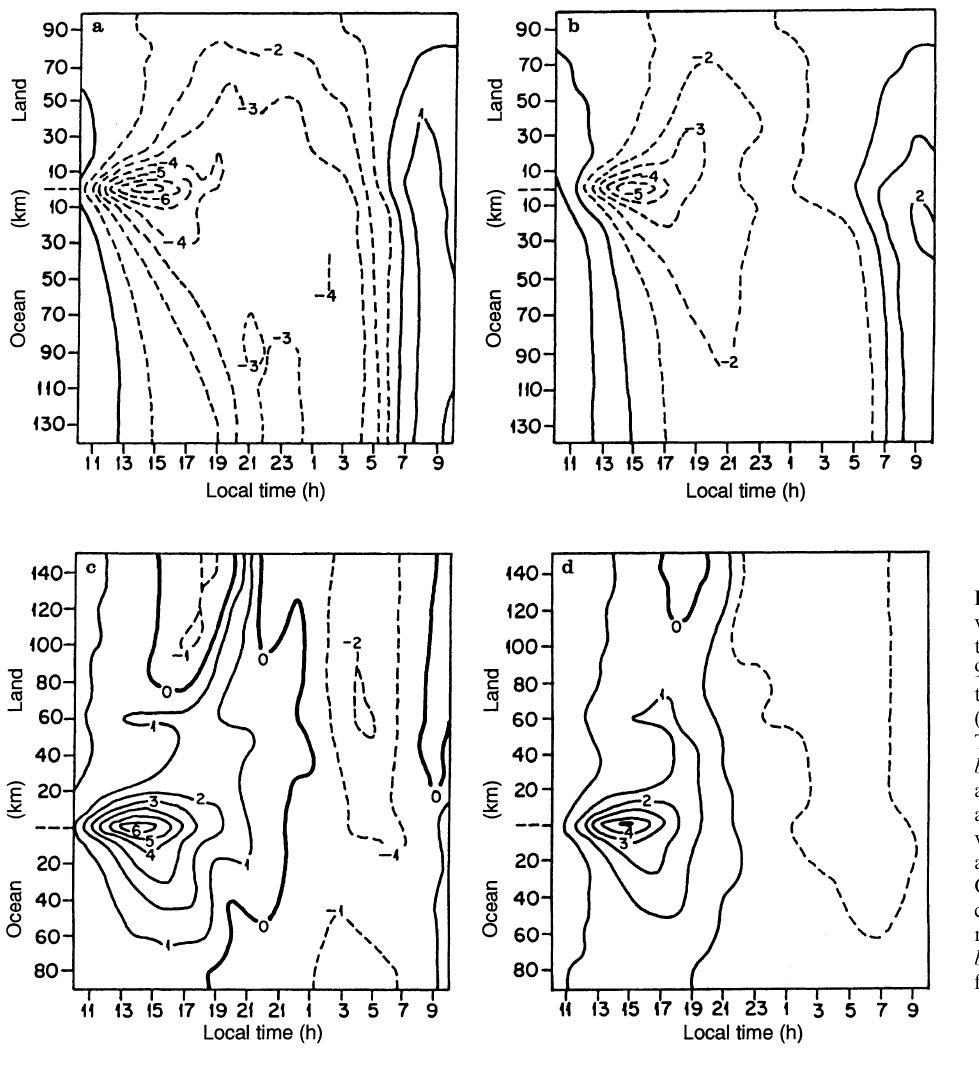
Fig. 6a–d. Simulated temporal variation of the horizontal ex- tension of the sea-breeze at the 990 hPa level: a EW variation of the u-component along line AB (Fig. 1) simulated for OND. The easterlies are indicated by broken lines ; and the westerlies are represented by solid lines ; b as a , except for AMJ; c SN variation of the v -component along line CD simulated for OND. The southerlies are indi- cated by solid lines and the northerlies are represented by a broken line ; and d as c , except for AMJ. Units are m s (cid:255)